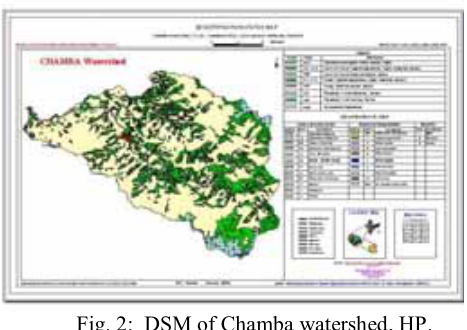
Fig. 4: Desertification Change detection (Nathusari Block, Ha- ryana).